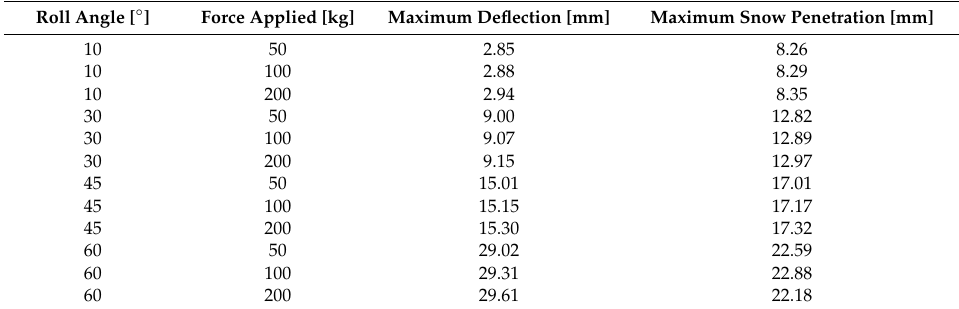
Table 4. Roll angles and forces